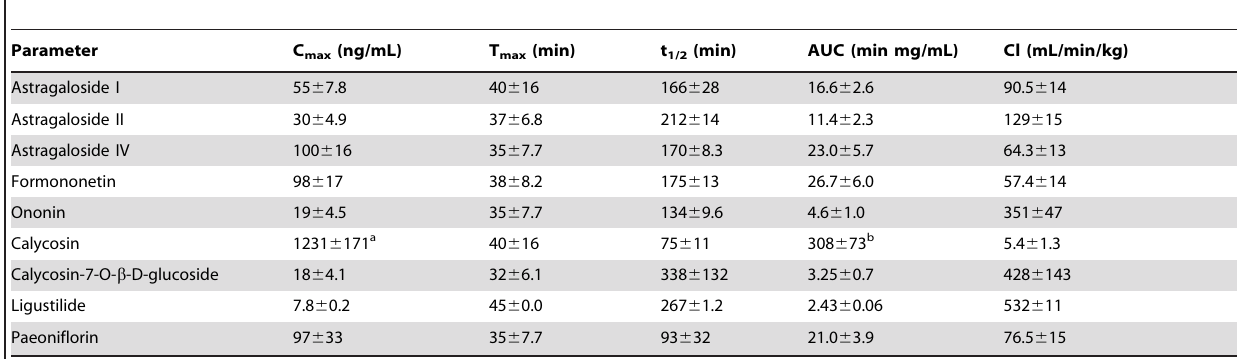
Table 5. Pharmacokinetic parameters of the nine compounds in rat after oral administration of bu-yang-huan-wu-tang.